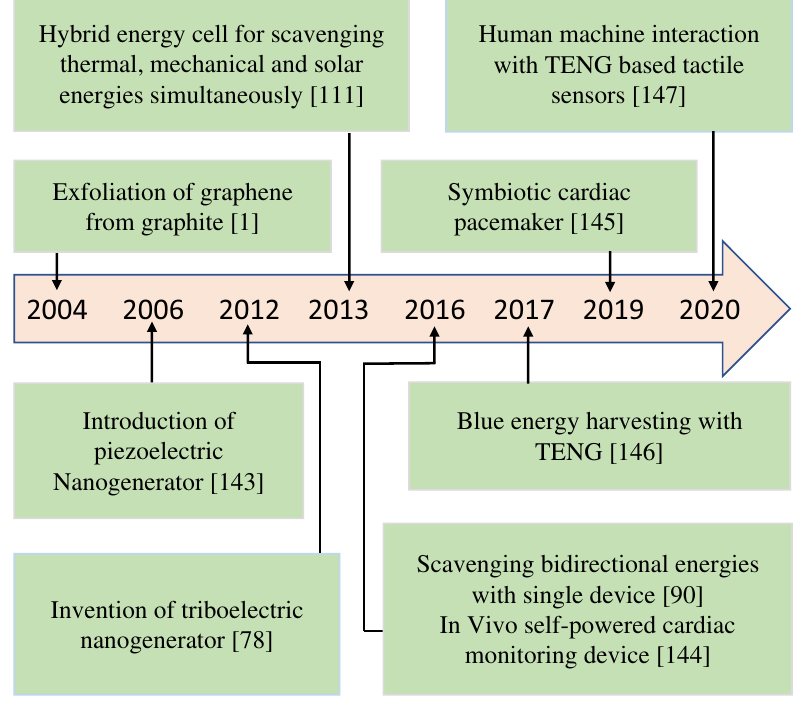
Fig. 13 A brief timeline profile of major achievements in the field of nanogenerator